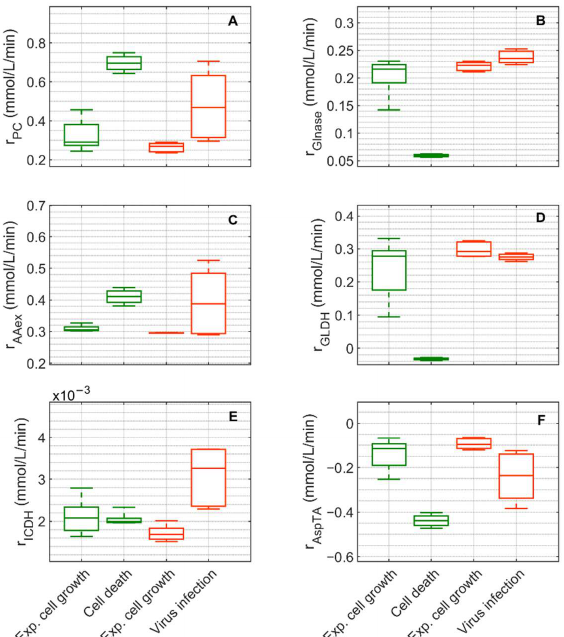
Figure 8. Box-and-whisker plot for selected intracellular rates of citric acid cycle, glutaminolysis and transamination estimated from model simulations for mock-infected and infected suspension MDCK cells. ( A ) pyruvate carboxylase, ( B ) glutaminase, ( C ) amino acid degradation, ( D ) glutamate dehydrogenase, ( E ) isocitrate dehydrogenase and ( F ) aspartate transaminase. Calculated from model simulations of the exponential growth phase of Cultivation 1 ( , 6–108 h), the death phase of Cultivation 1 ( , 146–169 h), the exponential growth phase of Cultivation 2 ( , 6–48 h) and the virus replication phase of Cultivation 2 ( , 49.9–107 h). The bar represents the median, the box is the first and third quartile, and the whisker the minimum and maximum of the rates from the model simulations of the corresponding cultivation phase.